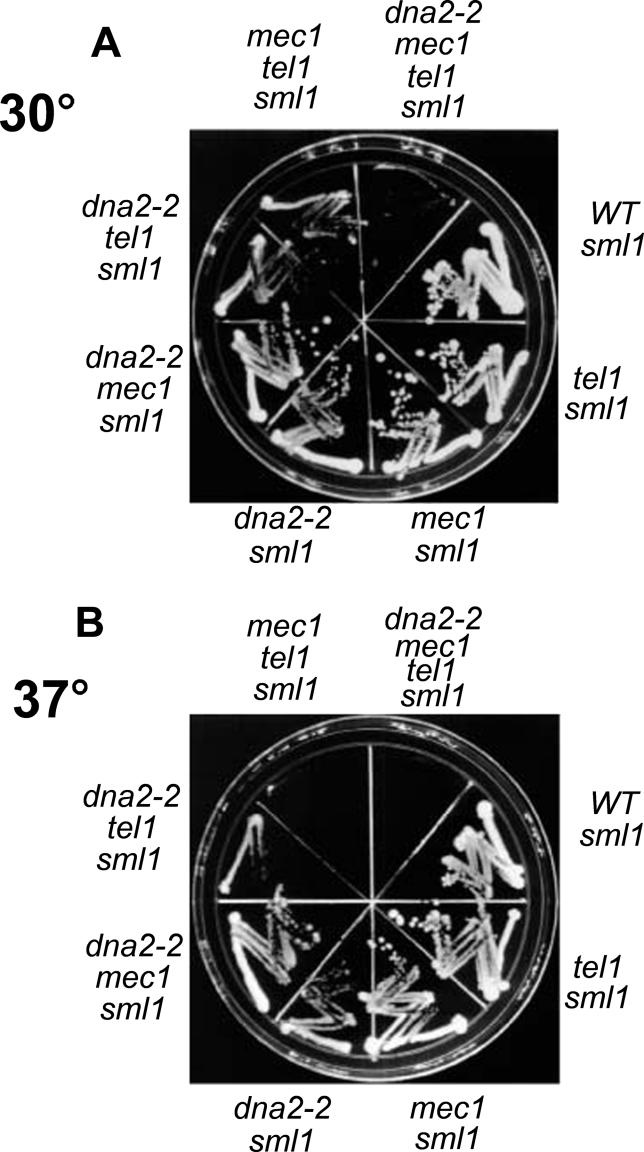
Synthetic Lethality of mec1Δ tel1Δ with dna2–2 MutationsStrains used in these experiments are listed in Table S4, and were isogenic or congenic with W303 RAD5
+. Segregants of a MEC1/mec1Δ TEL1/tel1Δ DNA2/dna2–2 SML1/sml1Δ diploid were placed on a YPD plate incubated at 30 °C (A) or 37 °C (B).